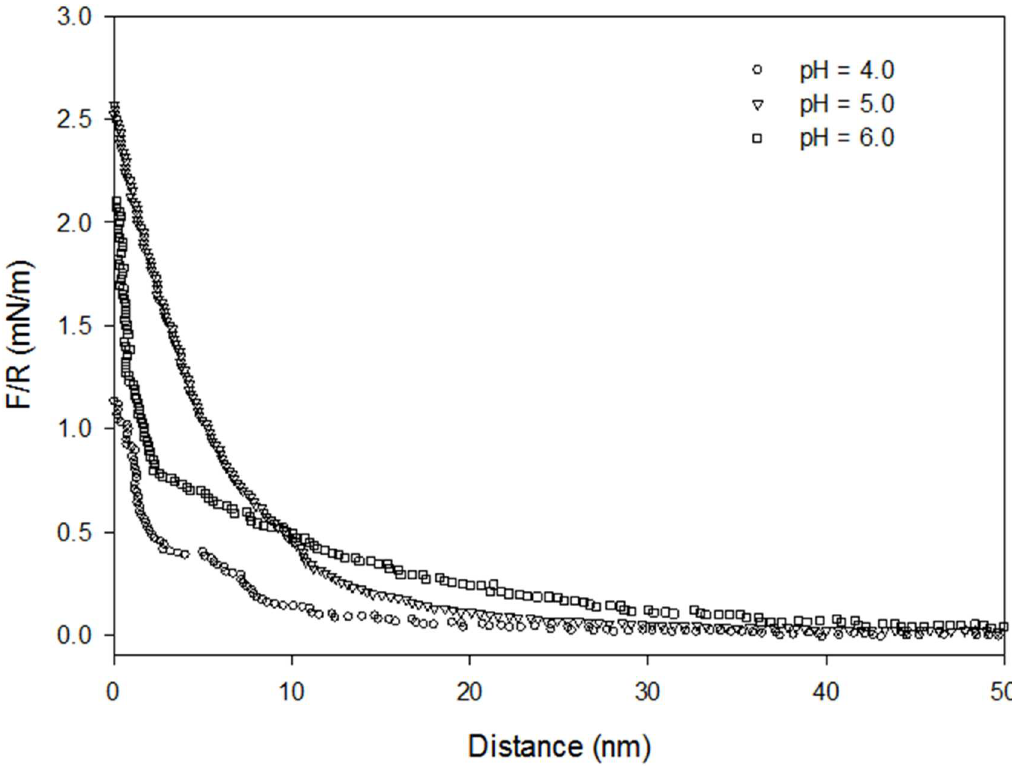
Fig 6. Effect of pH on the interaction between BSA and